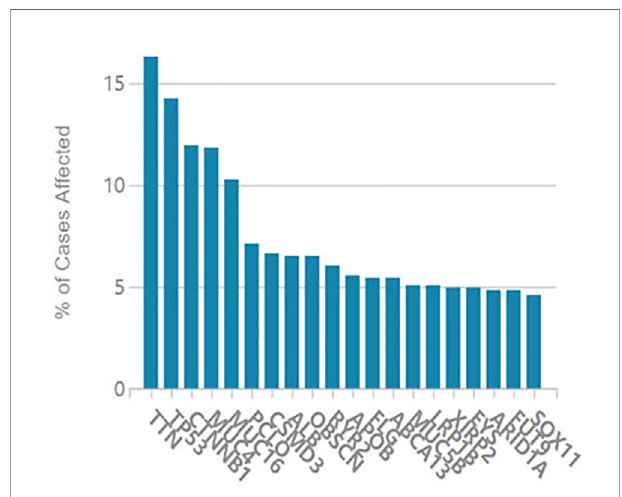
FIGURE 3 | Oncogene mutations in TCGA liver cancer